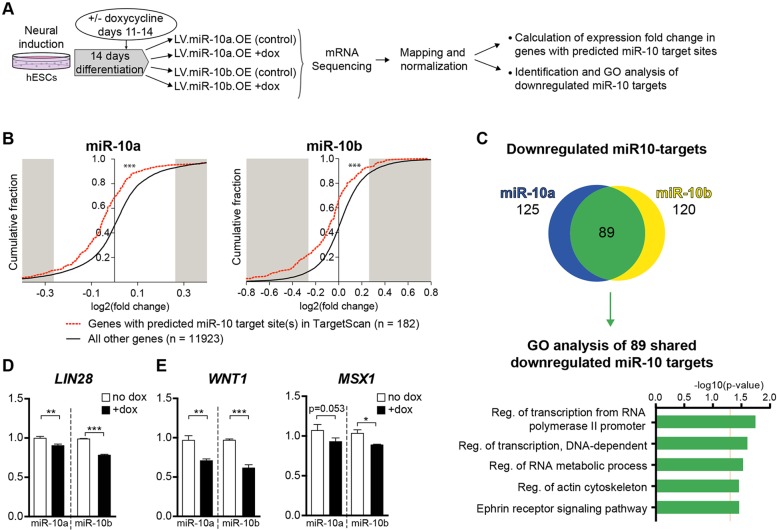
Identification of miR10 targets in hNPCs. (A) Schematic overview of the experiment. Transduced hESCs were differentiated towards ventral MB for 14 days. The expression of miR-10 was induced by adding doxycycline to the media on days 11-14, whereas no doxycycline was added to the control groups. All groups include three replicates. (B) The fold change (FC) of each gene after miR-10a or miR-10b overexpression was plotted in a cumulative fraction graph. The cumulative distribution of the FC values for predicted miR-10 targets (red dotted lines; n=182) was significantly lower (shifted to the left) in comparison to that of all other genes, demonstrating that expression of miR-10 target genes is downregulated by expression of miR-10a/b (black lines; n=11,923, ***P<0.0001, Kolmogorov–Smirnov Z-test). (C) A large number of downregulated targets (89) were shared between miR-10a and miR-10b overexpression. Gene ontology (GO) analysis was performed on the shared targets, revealing miR-10 to be involved in functions related to transcription, actin cytoskeleton and ephrin receptor signalling. (D) The expression of the miR-10 target gene LIN28 was downregulated by overexpression of miR-10a and miR-10b. (E) Both WNT1 and MSX1 take part in the midbrain/hindbrain patterning and were downregulated upon overexpression of miR-10a and miR-10b.